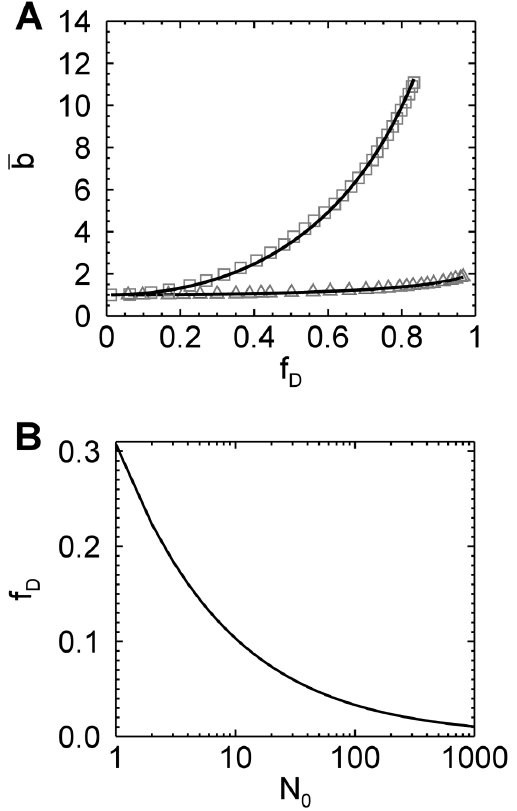
Figure 3. Time-averaged brightness bias. (A) The time-averaged brightness of Alexa488 as a function of the photodepletion fraction f D as measured in a microdroplet at a high (squares) and a low (triangles) concentration. The increase in brightness with f D is an artifact caused by photodepletion. The solid lines represent the fit of the data to Eq. 4, which resulted in N 0 of 16 and 0.69 for the high and low concentration data, respectively. (B) The relationship between photodepletion fraction f D and the initial number of fluorescent molecules N 0 in the